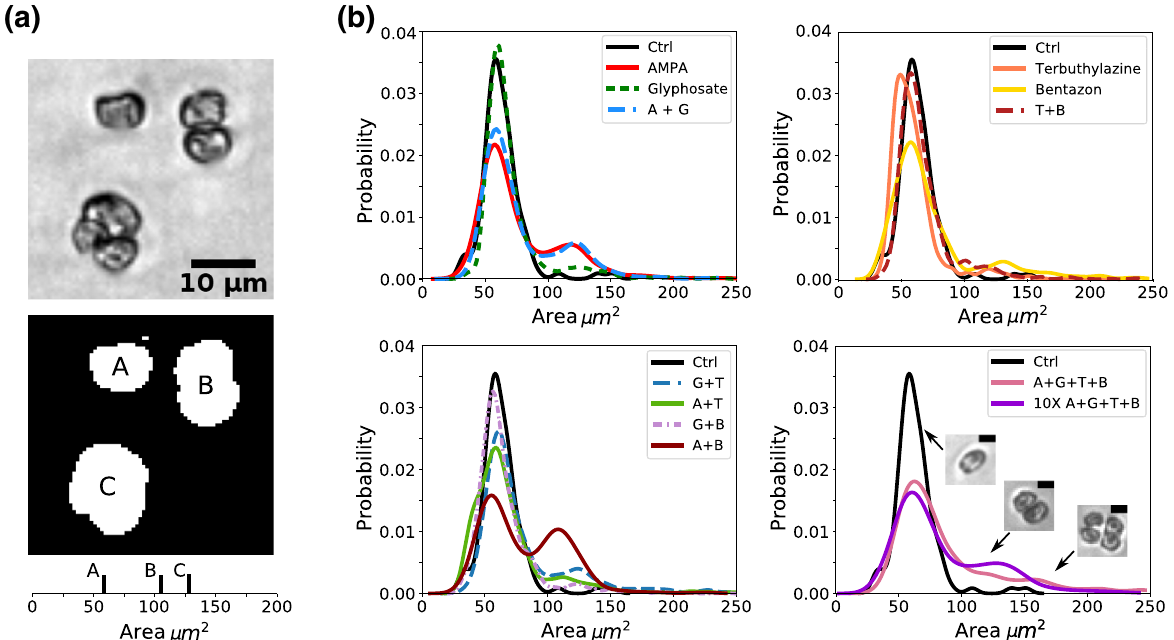
Figure 5. ( a ) Figure shows an exemplified image of C. reinhardtii single cell and aggregates of two and more cells. Binary masking was created in order to calculate the area of each cell/aggregate. Bottom panel shows the values obtained for the three particles shown. Note that area of the aggregate does not scale linearly with the number of particles due to three-dimensional conformation of the aggregates. ( b ) Size particle distribution obtained as described in ( a ) and in MM section for all the experimental conditions, as in legend. The presence of multiple peaks in the distributions suggests the presence of aggregates, expecially in presence of AMPA and AMPA in combination with Bentazon (A + B) compared to control condition. The presence of all the four substances at concentration equal to the one detected in surface waters (A + G + T + B) or ten times higher (10 × A + G + B + T) gives a broad distribution of